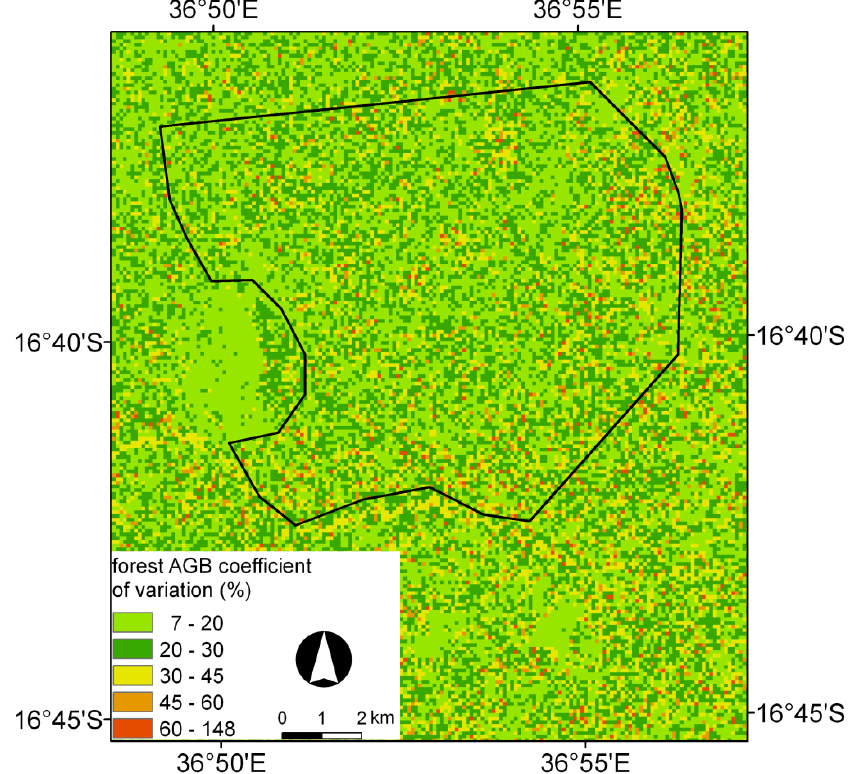
Figure 7. Forest AGB uncertainty classes map of the study area (outlined) obtained with the coefficient of variation (%) resulting from the application of the fitted BagSGB model. The minimum and maximum values presented in the legend are for the area encompassing the mosaic of the two ALOS PALSAR scenes used. In the study area (~10,000 ha), the minimum and maximum forest AGB coefficient of variation values were 10% and 119%,